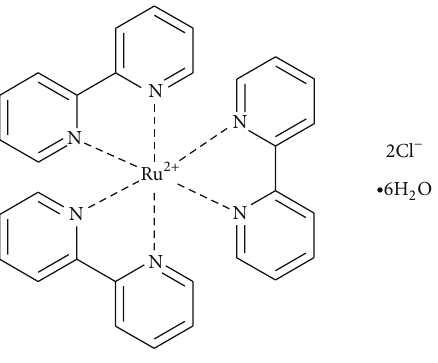
Figure 2: Molecular structure of tris(2,2 󸀠 -bipyridyl)ruthenium(II) dichloride hexahydrate